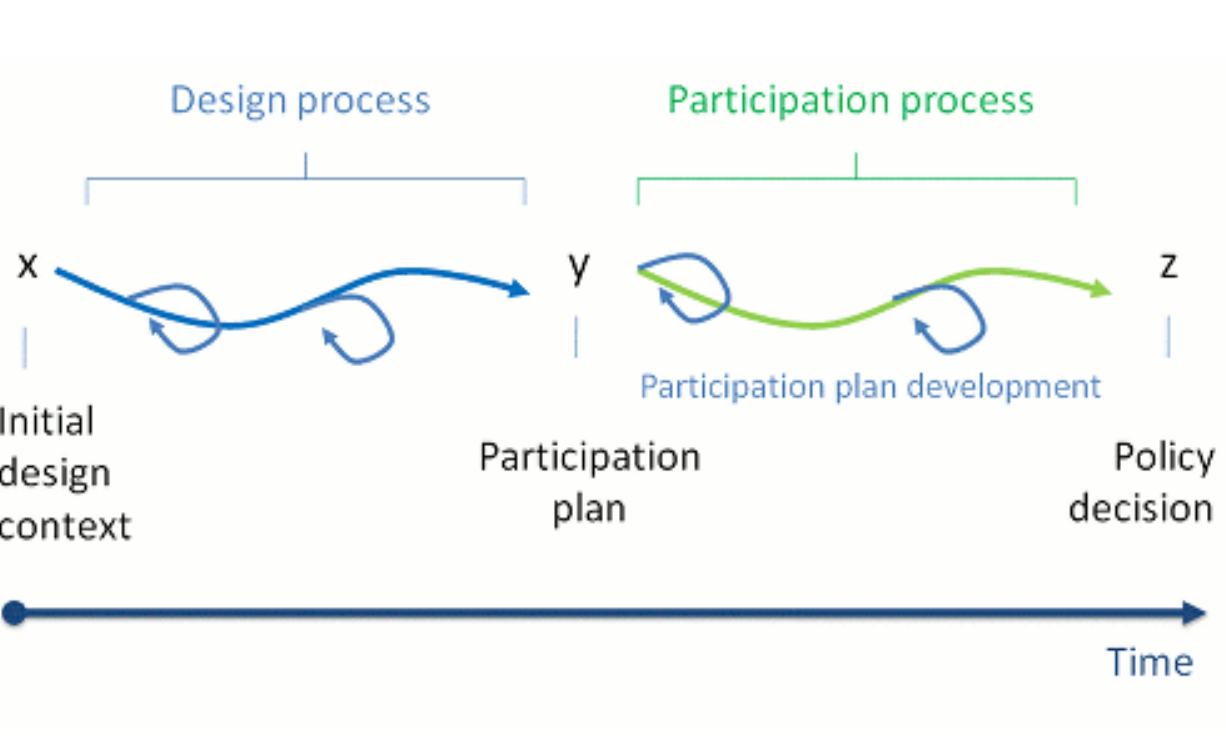
Fig. 1. Defining process